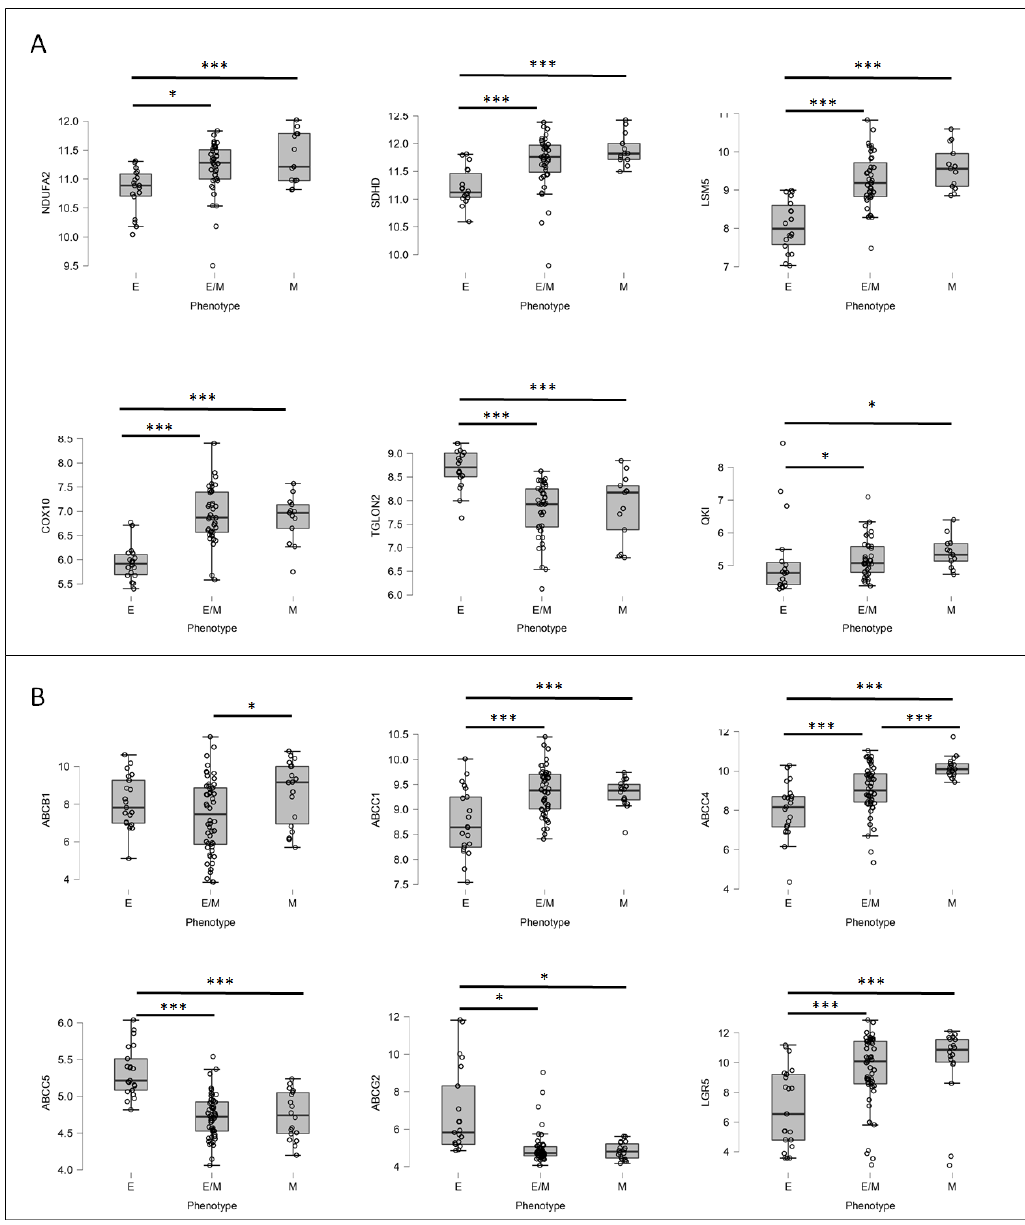
Figure 8. The mRNA expression levels of FOLFIRI-resistant DEGs ( A ) and major ABC proteins ( B ) in various EMT states in patient samples. Patient samples (n = 111) from GSE18105 were divided